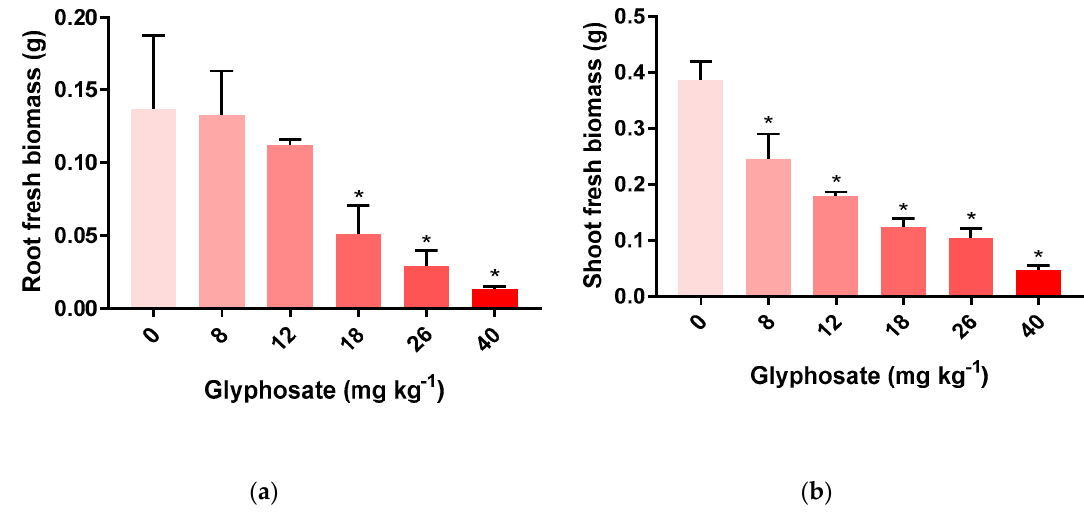
Figure 2. Average biomass of roots ( a ) and shoots ( b ) of M. sativa plants, 21 days after exposure to increased concentrations of GLY. Error bars correspond to the standard deviation. Statistically significant differences compared to the CTL, considering p ≤ 0.05, are marked with a * above bars.